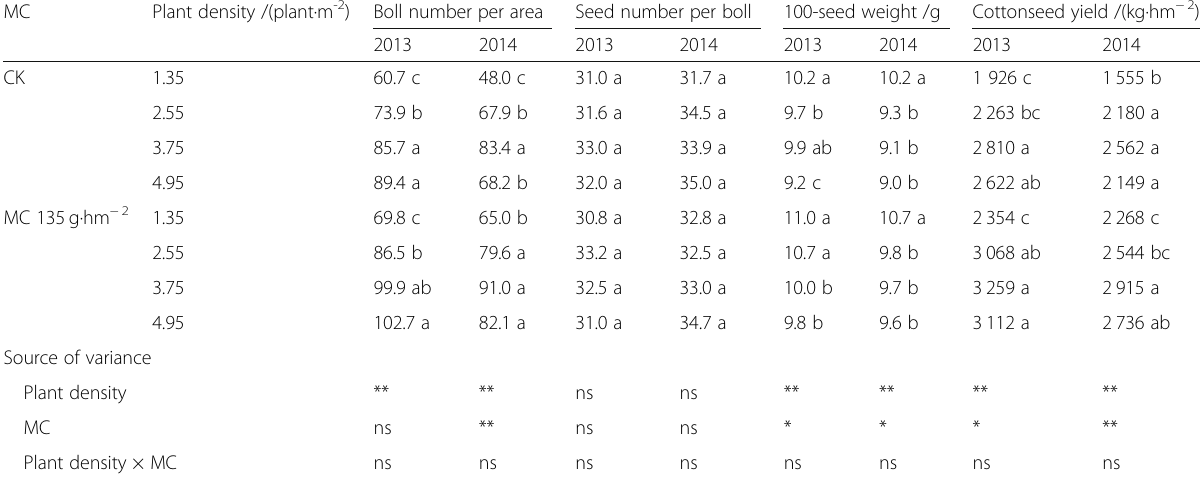
Table 2 Effects of mepiquat chloride (MC) on cottonseed yield and yield components under different plant densities in Sikang